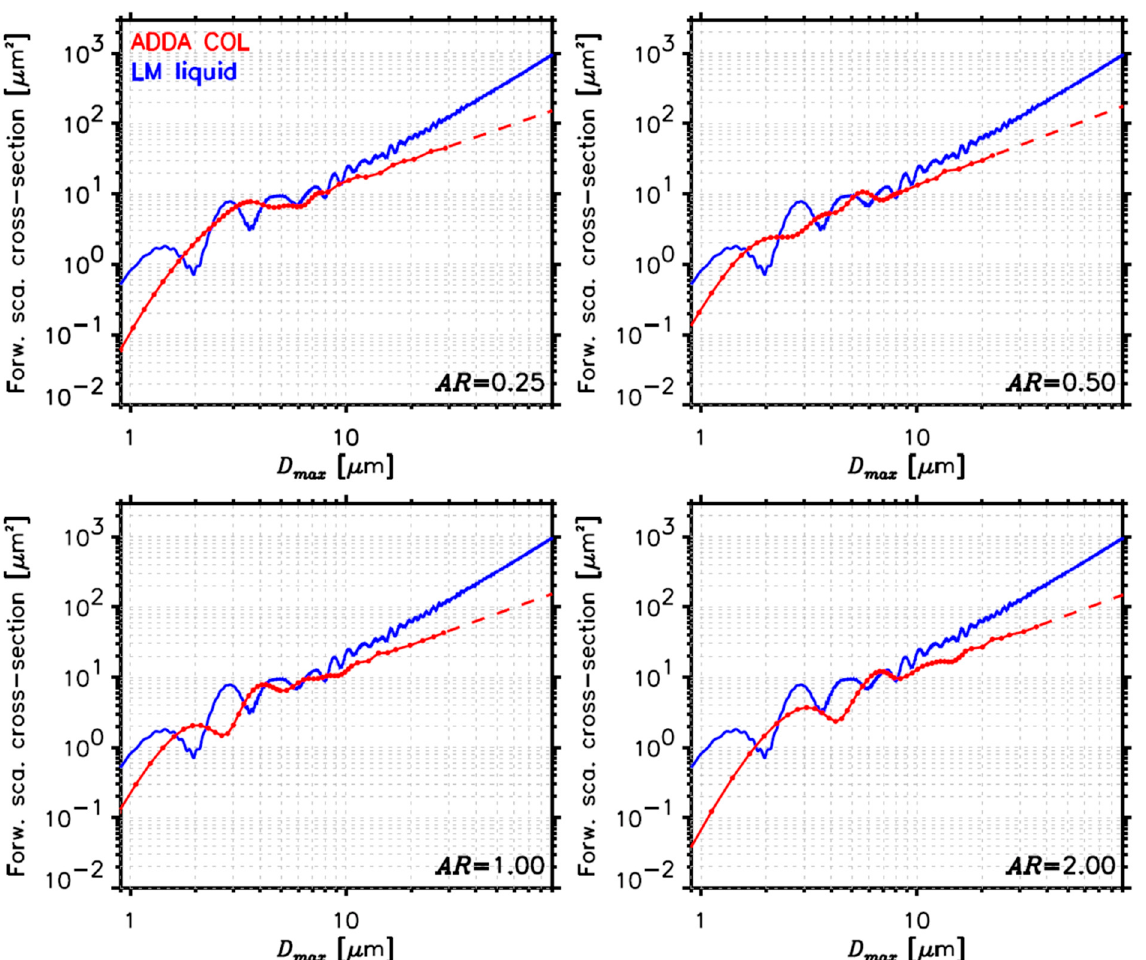
Figure 4. Calculated forward (4°–12°) scattering cross-sections of hexagonal ice crystals (red) and spherical liquid cloud droplets (blue) as functions of maximum dimensions of hexagonal ice crystals and spherical liquid cloud droplets using the ADDA and Lorenz–Mie code, respectively, for four different aspect ratios of AR = 0.25, 0.50, 1.00, and 2.00. The extrapolated scattering cross-sections of hexagonal ice crystals are shown with red broken lines.